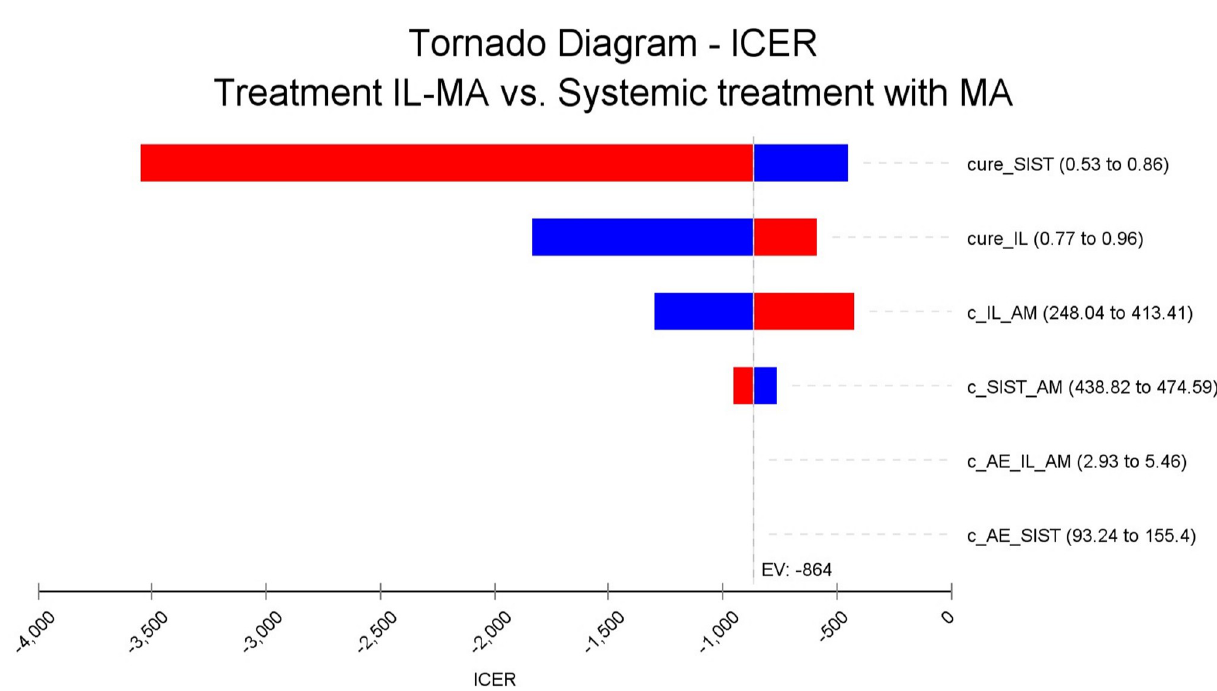
Fig 2. Tornado diagram of deterministic sensitivity analysis. Notes: Vertical line represents final ICER. Critical variables are represented as horizontal bars. All variables crossed final ICER, which means that none of them was able to affect the result. cure_SIST: cure rate for endovenous meglumine antimoniate therapy; cure_IL: cure rate for meglumine antimoniate intralesional infiltration; c_IL_AM: total cost for meglumine antimoniate intralesional infiltration; c_SIST_AM: total cost for endovenous meglumine antimoniate therapy; c_AE_IL_AM: total cost related to adverse events during IL-MA; c_AE_SIST: total cost related to adverse events during EV-MA.